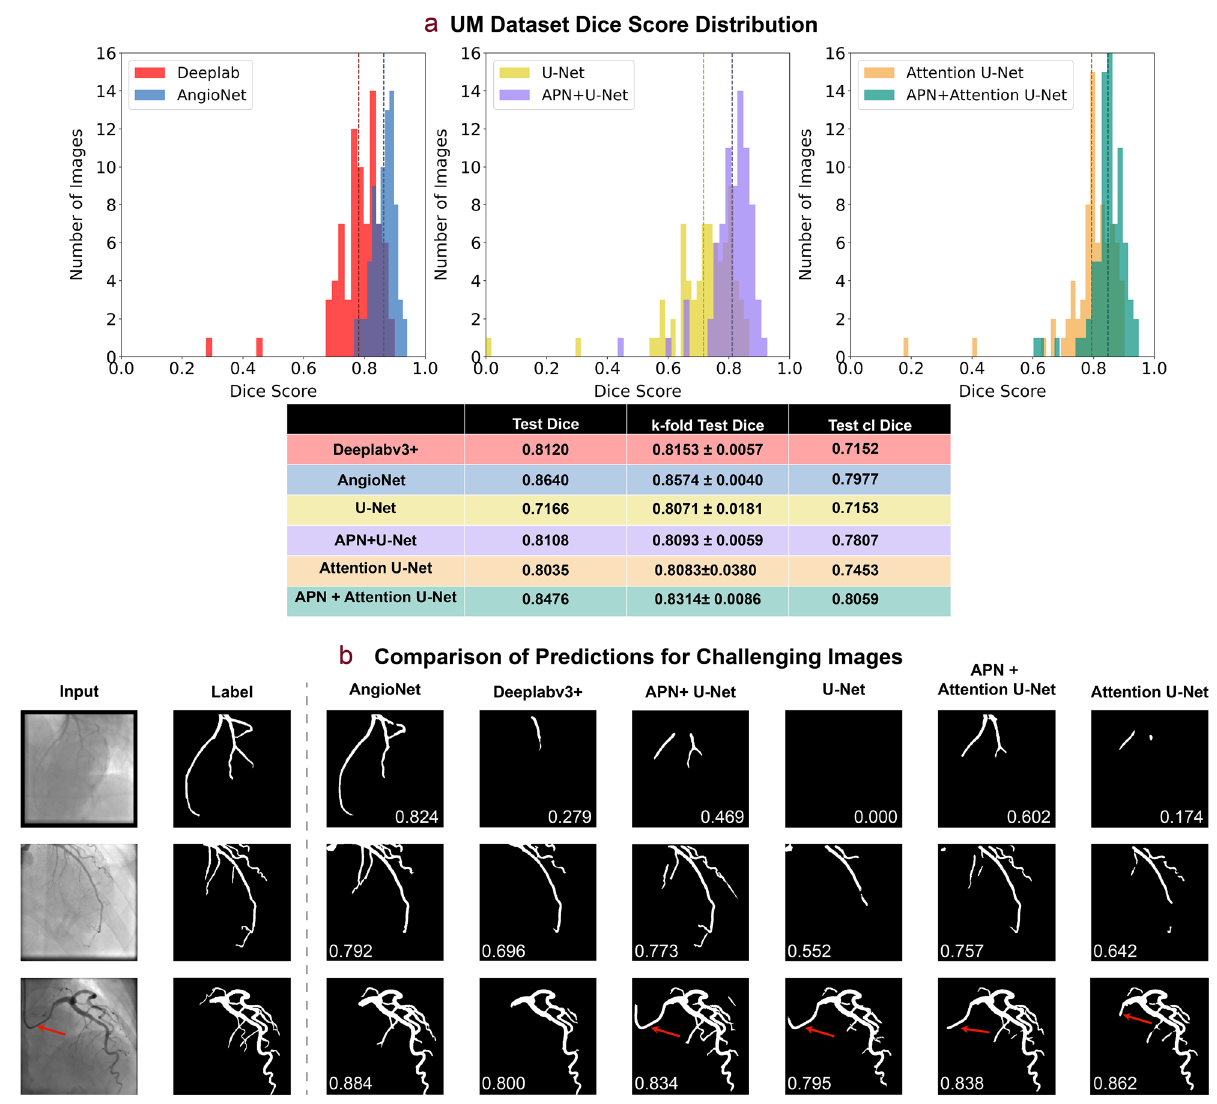
Figure 6. Summary of APN performance. All results are derived from the networks trained on all five partitions of the UM training set, unless otherwise noted as a k-fold result. ( a ) Comparison of Dice score distribution on test set. AngioNet has the highest average Dice score, with scores ranging from 0.737 to 0.946. Adding the APN improves the Dice scores of all backbone networks (Deeplabv3+, U-Net, and Attention U-Net). Dashed lines correspond to the Test Dice in the table below. clDice is also summarized in the table, with the Attention U-Net backbone demonstrating highest topology preservation. ( b ) Segmentation comparison on challenging images with low contrast, faint vessels, and a curved catheter. AngioNet can segment more vessels in these images without segmenting the catheter (red networks, as Attention U-Net segmented the catheter in 11.7% of images and APN + Attention U-Net included in the catheter in 9.1% of images. Evaluation of vessel diameter accuracy versus QCA.